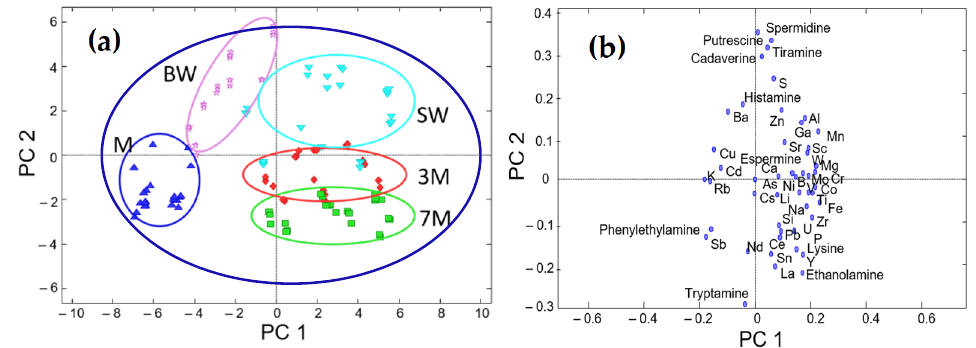
Figure 1. Plots of scores ( a ) and loadings ( b ) from the low-level data fusion. ( a ) Scatter plot of PC1 vs. PC2 scores; ( b ) scatter plot of PC1 vs. PC2 loadings. Sample assignment: M = must (blue); BW = base wine (light purple); SW = stabilized wine (light blue); 3M = sparkling wine with 3 months aging (red); 7M = sparkling wine with 7 months aging (green).